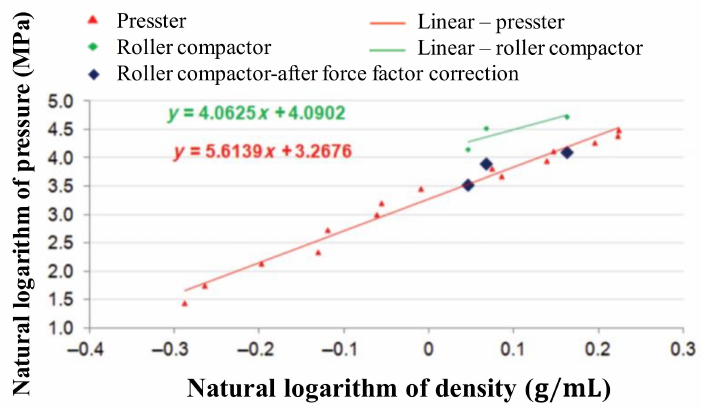
Figure 11. Plot of density against pressure applied using a presser and roller compactor [147]. The figure was slightly modified, with permission from